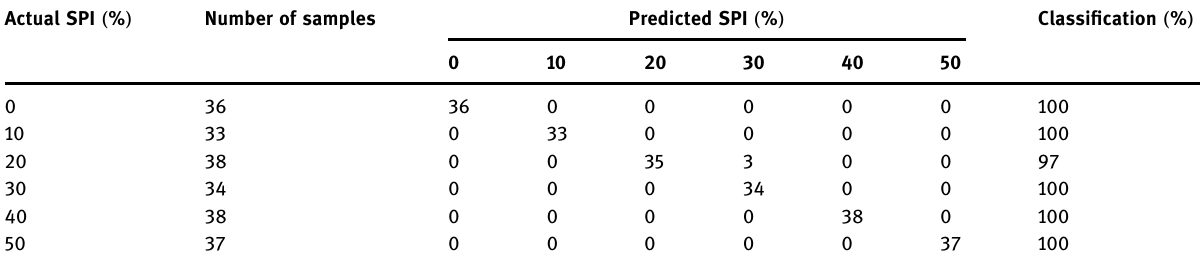
Table 3: PCA - DA classi fi cation model for pure and SPI - added butter fl y - pea extract powder Actual SPI ( % )